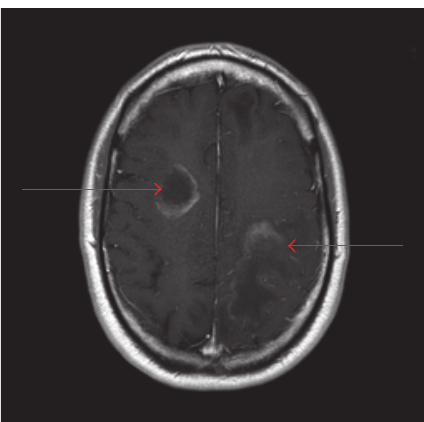
Figure 1: Brain MRI with bilateral peripherally enhancing white matter lesions representing signs of active demyelination.